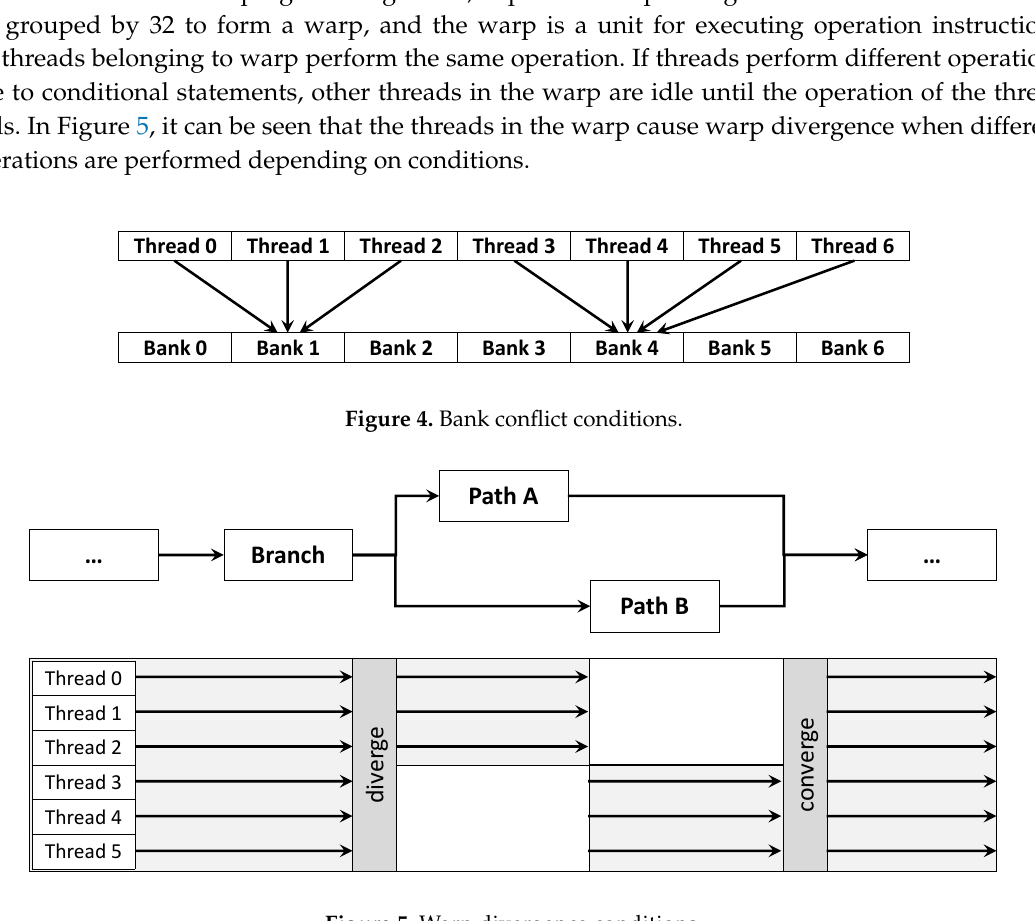
Figure 5. Warp divergence